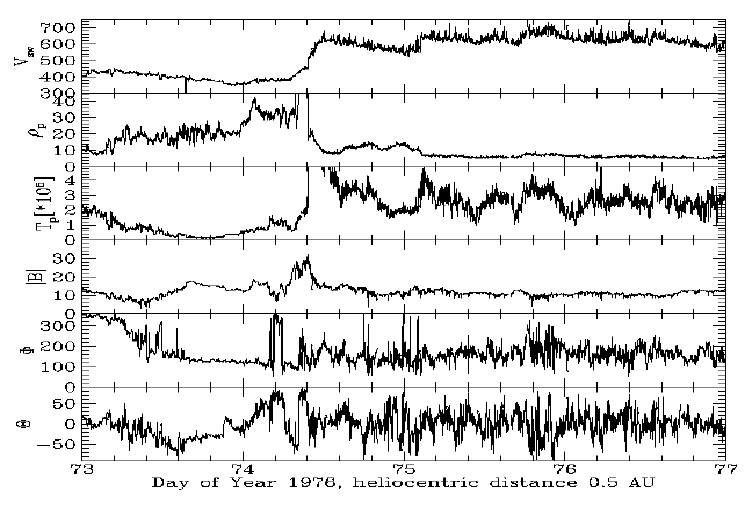
Figure 18: High velocity streams and slow wind as seen in the ecliptic during solar